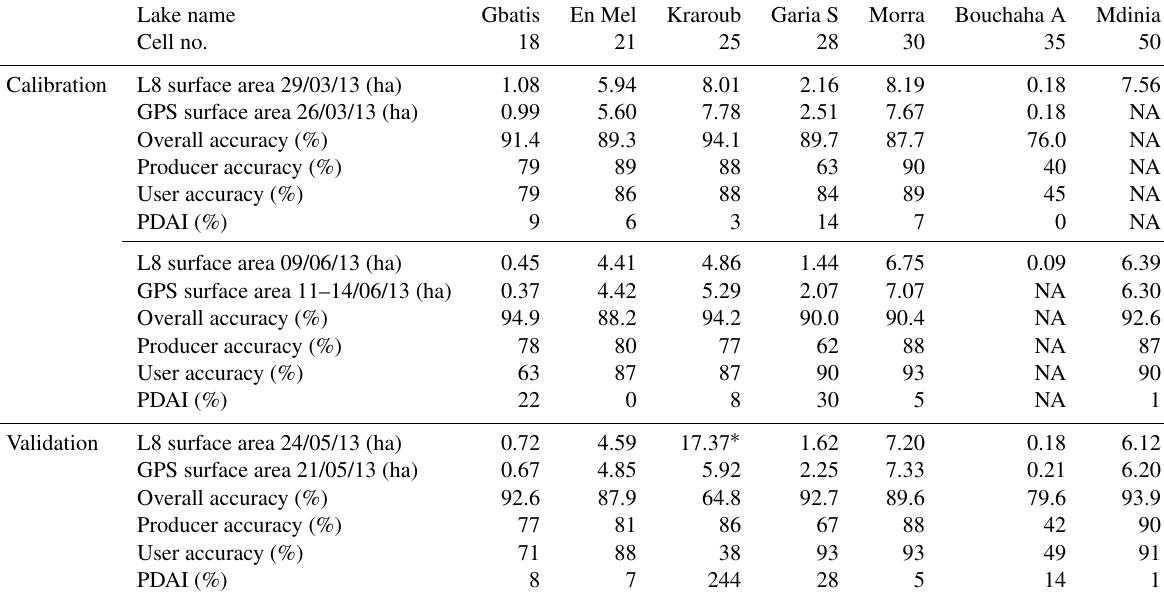
Table 2. Landsat 8 MNDWI flooded surface area assessments compared to field measurements for seven lakes on the calibration and valida- tion images